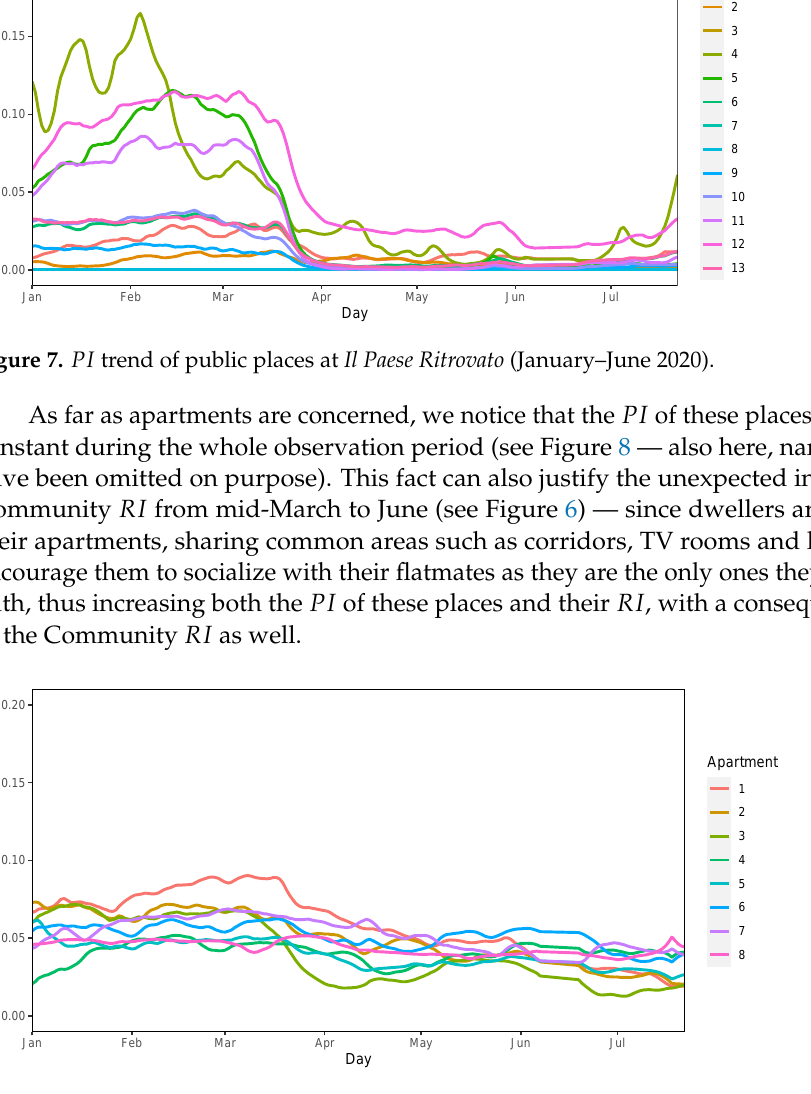
Figure 8. PI trend of private places at Il Paese Ritrovato (January–June